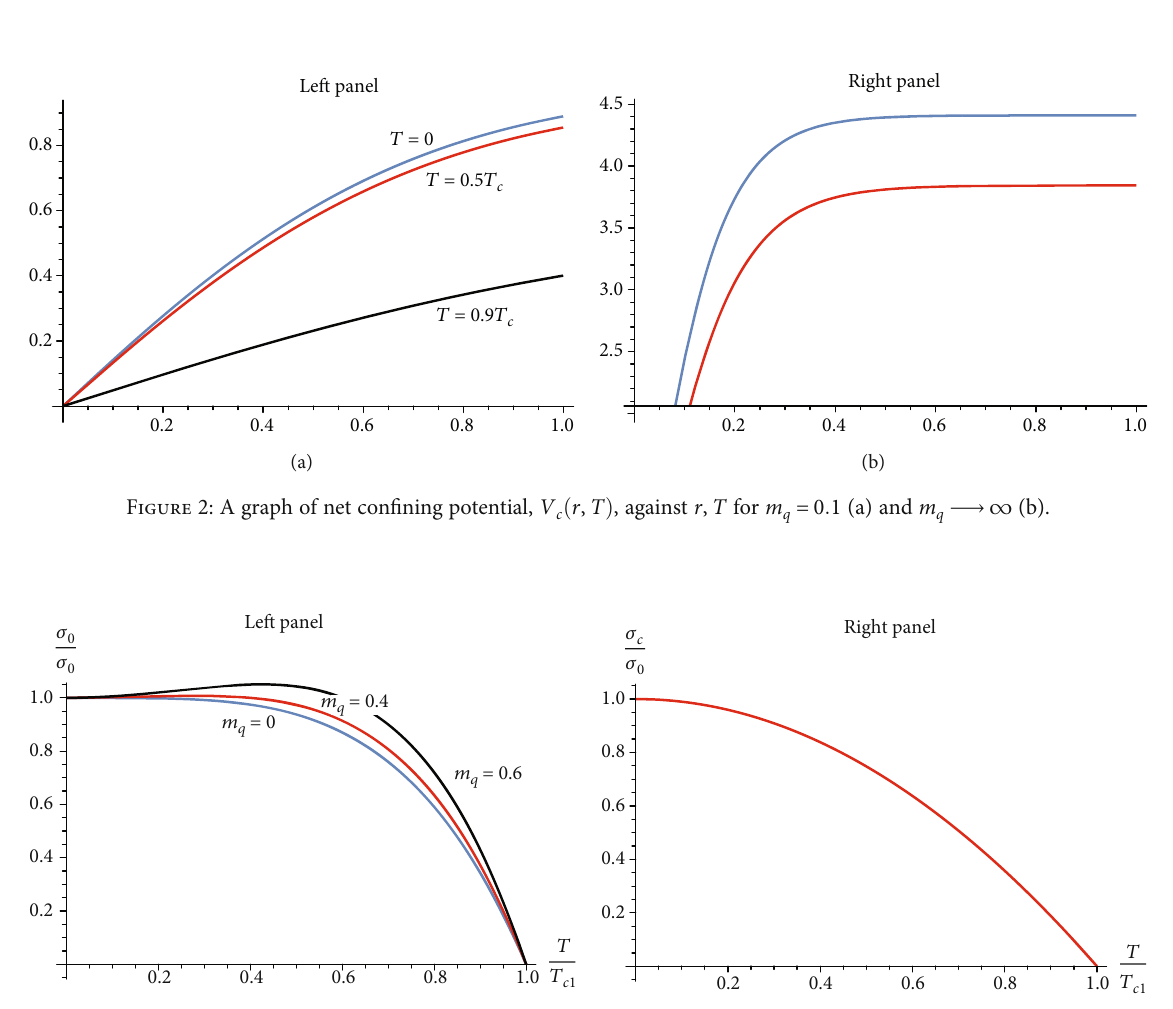
= 0 : 1 (a) and m ⟶ ∞ (b). q q